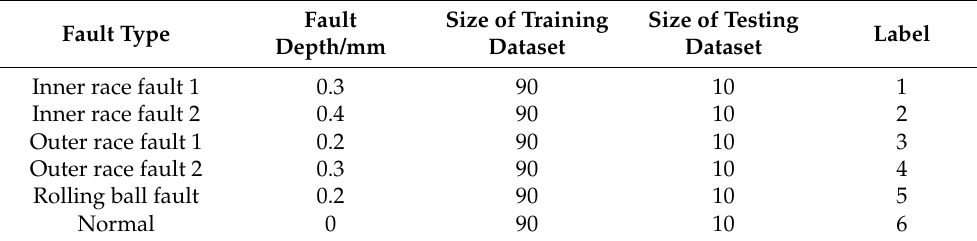
Table 1. Bearing dataset